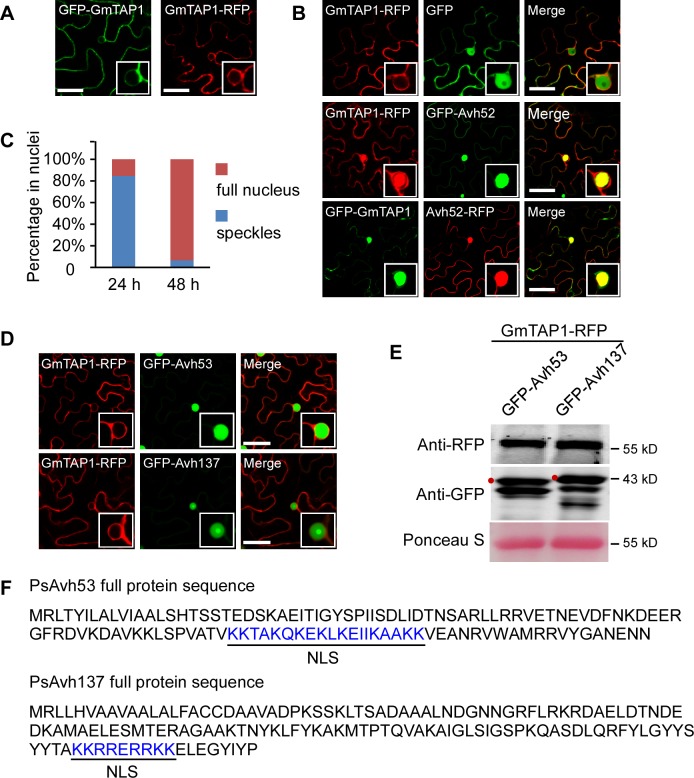
The localization of GmTAP1 and effectors in N.benthamiana.(A) Localization of N-terminal GFP-labeled GmTAP1 and C-terminal RFP-labeled GmTAP1 in N. benthamiana leaf cells. (B) Localization of PsAvh52 and GmTAP1 after extended co-expression (36 hr to 48 hr) in N. benthamiana leaf cells. (C) Percentages of nuclei showing co-localization of GFP-GmTAP1 and PsAvh52-RFP in nuclear speckles versus the full nucleus following different times of expression. (D) Localization of GmTAP1-RFP after co-expression with two other nuclear targeted effectors fused to GFP in N. benthamiana leaf cells. In (A, B, D) scale bars = 50 µm. (E) Protein levels of GmTAP1-RFP and GFP-effectors when co-expressed in N. benthamiana leaf tissue, as detected in western blots with the indicated antibodies. Loading control was Ponceau-stained Rubisco. (F) The full predicted amino acid sequences of PsAvh53 and PsAvh137 with predicted NLS sequences highlighted in blue.